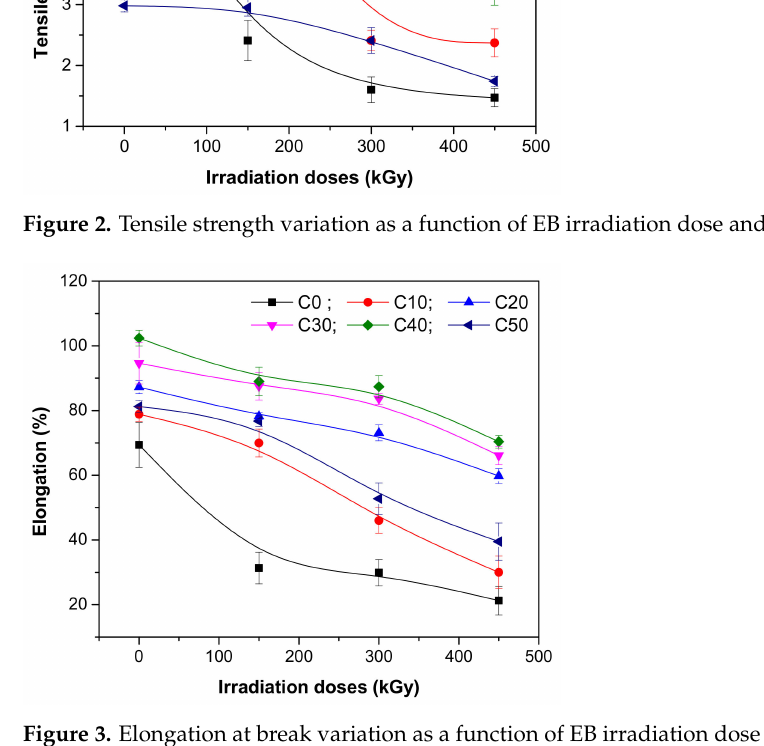
Figure 3. Elongation at break variation as a function of EB irradiation dose and PS